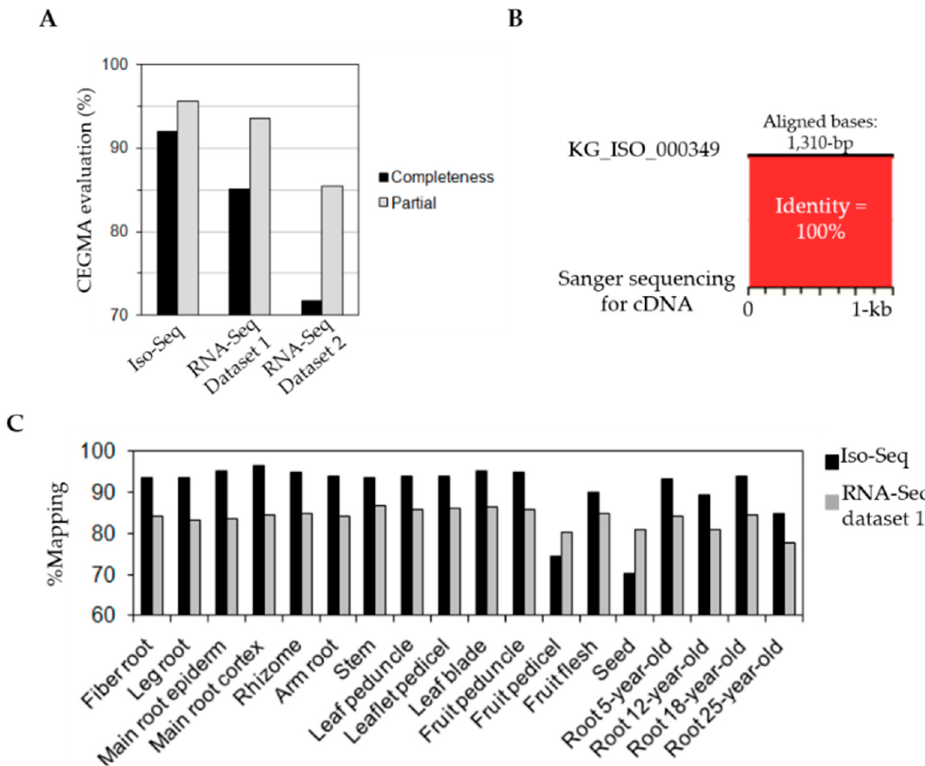
Figure 2. Performance assessment of P. ginseng Iso-Seq. ( A ) CEGMA evaluation. The completeness (%) of de novo assemblies from Iso-Seq and RNA-Seq data were assessed by CEGMA. In the result, RNA-Seq dataset 1 and dataset 2 unigenes were generated from data by Wang et al. (2016) [13] and from our unpublished leaf RNA-Seq data, respectively. ( B ) Validation of an unigene by Sanger sequencing. Sequence identity between unigene KG_ISO_000349 and the corresponding Sanger sequence was examined using zPicture. ( C ) Performance assessment of P. ginseng Iso-Seq. Mapping of RNA-seq dataset 1, derived from 16 tissues, to the two unigene sets assembled from Iso-Seq and RNA-Seq dataset 1 of P. ginseng using BWA.